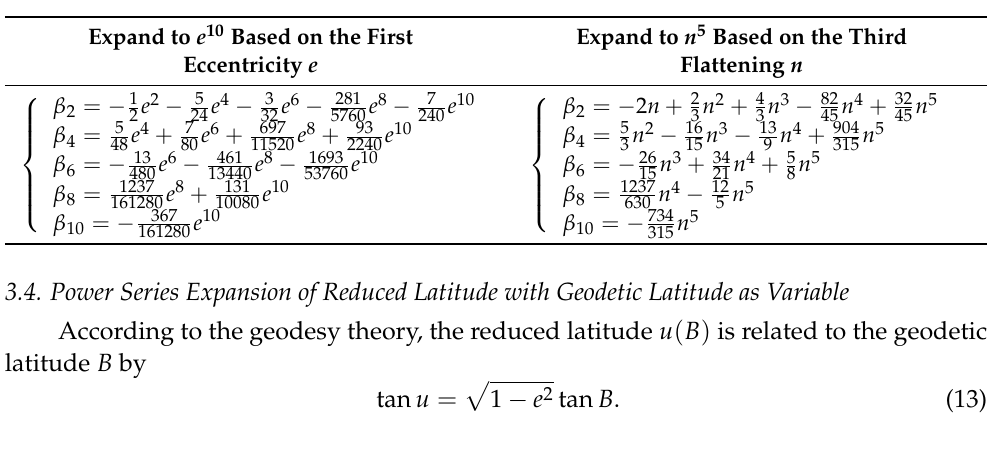
Table 3. Coefficients in Equation